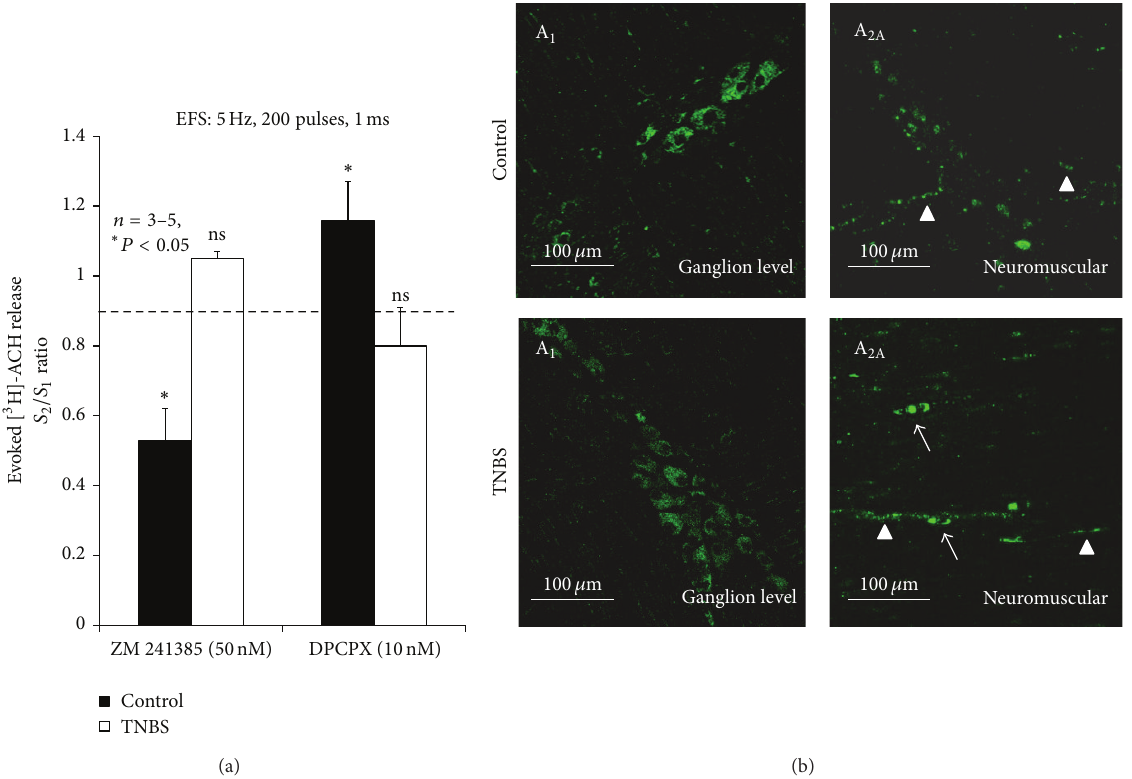
Figure 2: (a) Actions of selective adenosine A 1 and A 2 receptor antagonists on [ 3 H]-ACh release from myenteric motoneurons stimulated A receptor antagonist) were electrically (5 Hz, 200 pulses, 1ms duration). DPCPX (10nM, A 1 receptor antagonist) and ZM 241385 (50 nM, A 2 A addedtotheincubationmediabeforethesecondperiodofstimulation( S 2 )andwerepresentthroughouttheassay.Theordinatesarechangesin S 2 / S 1 ratios compared to the S 2 / S 1 ratio obtained in control conditions, that is, with no drugs added. The data are means ± SEM of three to five individual experiments. ∗ 𝑃 < 0.05 (one-way ANOVA followed by Dunnett’s modified t -test) represent significant differences when compared tothesituationwherenodrugswereadded(dashedline).(b)Confocalimagesofwhole-mountpreparationsoflongitudinalmuscle-myenteric plexus preparations of the ileum from control and TNBS-injected rats. Adenosine A 1 receptor immunoreactivity is predominantly present in receptor imunoreactivity is mainly present in nerve ganglion neuronal cell bodies in control and TNBS-injected preparations. Adenosine A 2 A receptor staining is also observed in bundles and axon terminals of myenteric neurons (triangles). In inflamed preparations, adenosine A 2 A few mononuclear cells infiltrating the neuromuscular layer